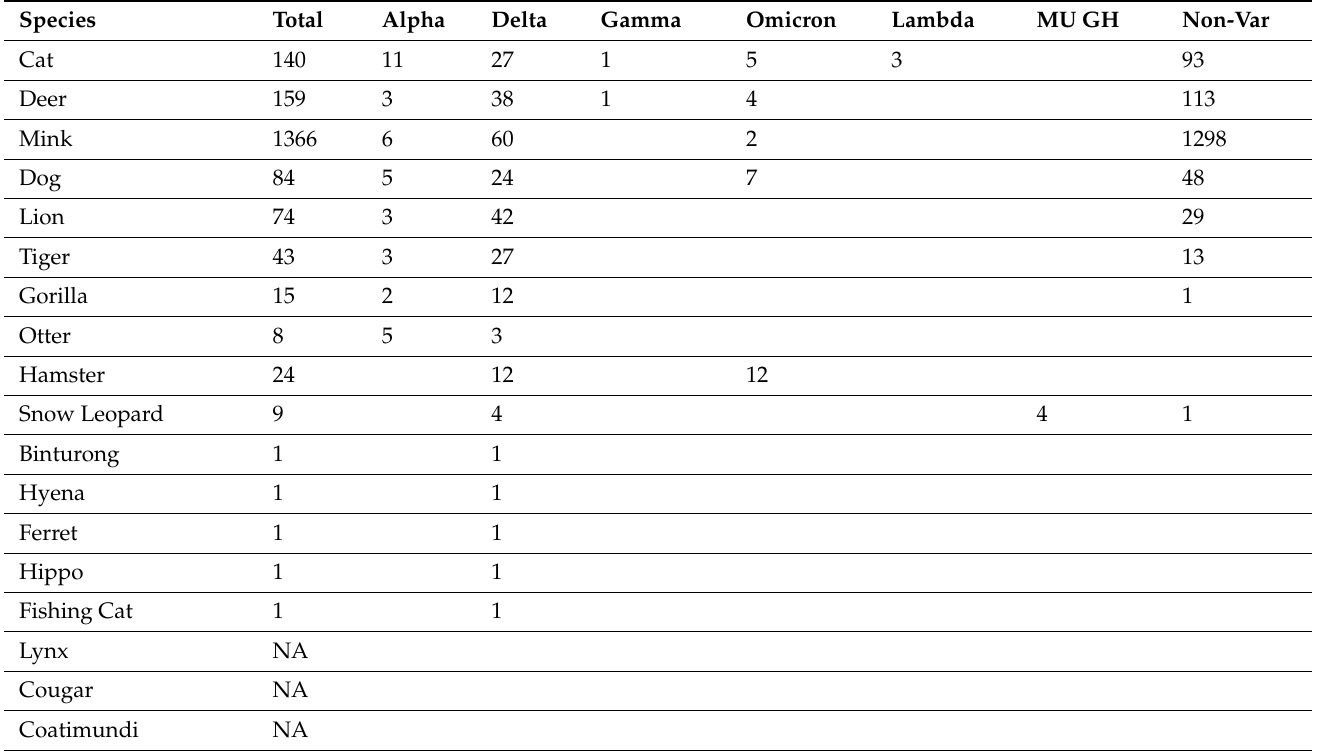
Table 1. Number of sequences of variant and nonvariant strains of SARS-CoV-2 in 18 animal species. GISAID SARS-CoV-2 sequence database was accessed on 12 May 2022. NA: not available; Non-Var: